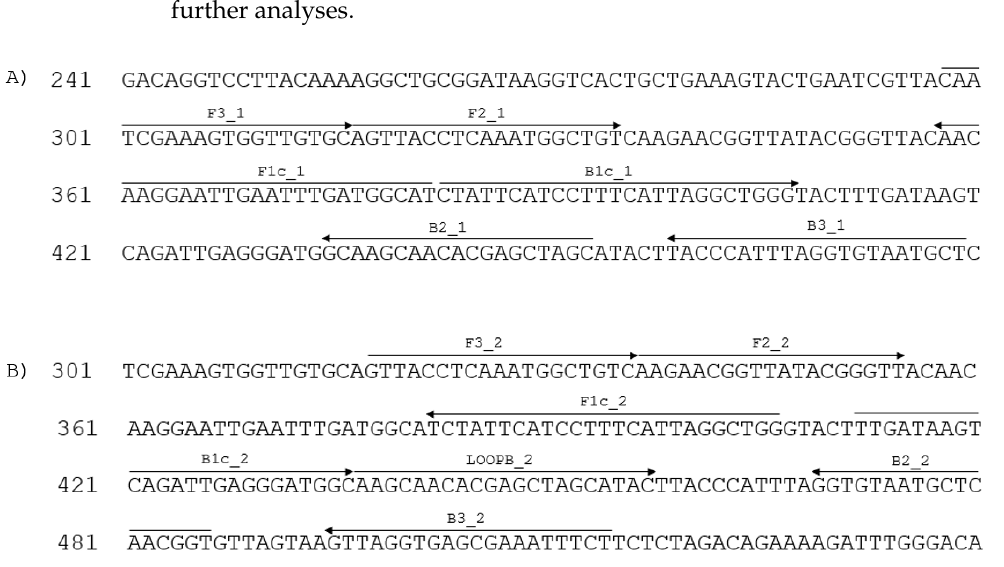
Figure 1. Positions of LAMP primers on SBCMV RNA2 sequence AJ132577. Arrowheads indicate the orientation of the primer. ( A ): primer set 1; ( B ): primer set 2.